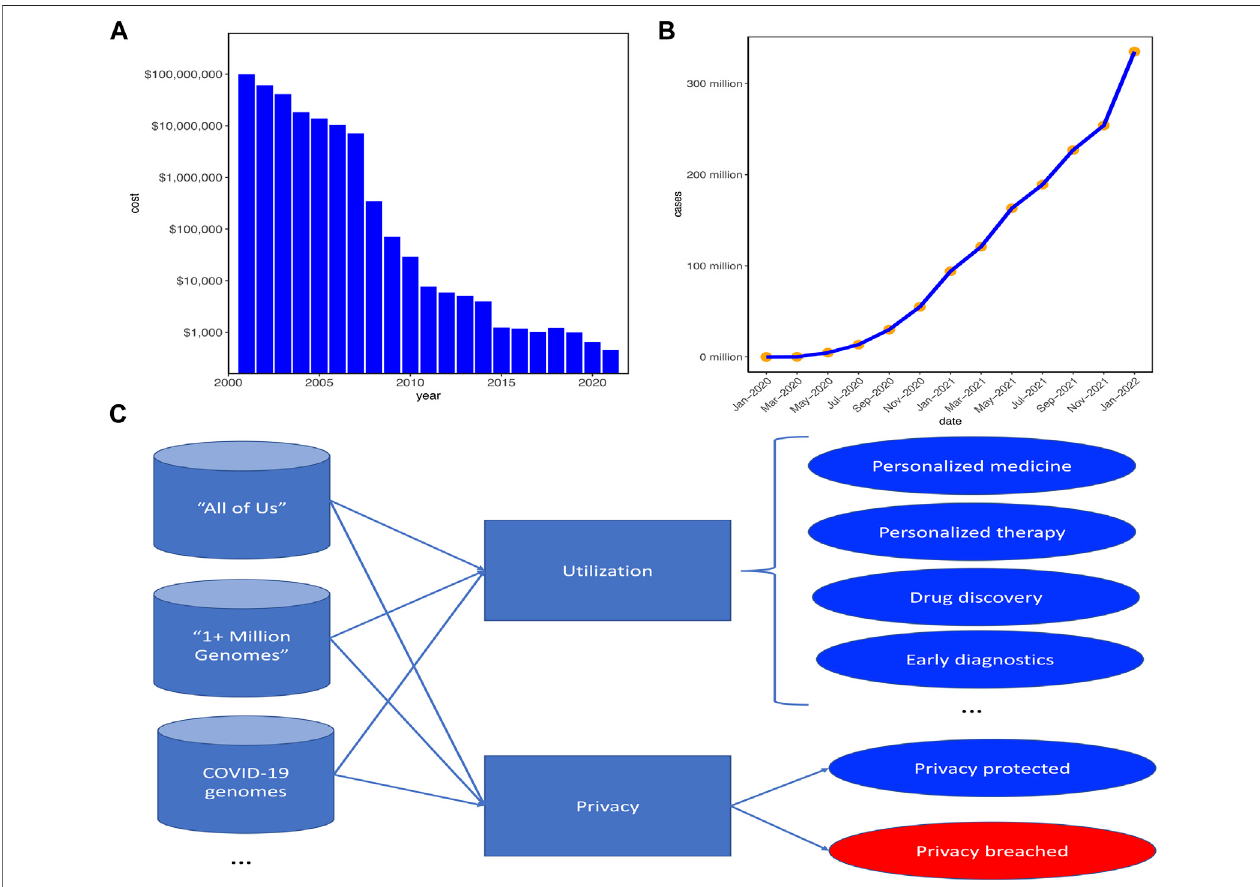
FIGURE 1 | Current status of personal genomic data for utilization and privacy. (A) The whole genome sequencing (WGS) cost decreased signi fi cantly with the technologicaladvancesinrecentdecades. (B) ThenumberofCOVID-19casesincreasedsigni fi cantlyinthese2 yearsandconcurrentlythenumberofpersonalgenomic data would increase. (C) Large-scale projects have been launched for betterment of human healthcare while simultaneously posing serious challenges on protecting individualgenomic privacy. “ AllofUs ” (https://allofus.nih.gov/) waslaunched byUSand “ 1+Million Genomes ” (https://digital-strategy.ec.europa.eu/en/policies/1- million-genomes) was initialized by the European Union. Blue circles represent good bene fi ts of genomic data utilization or privacy well proteted, whereas the red circle represents the challenge of genomic data privacy breached.